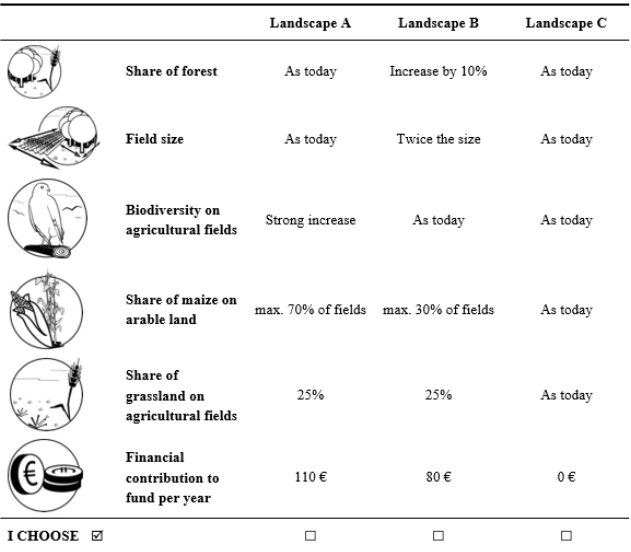
Figure 1. Example of a choice